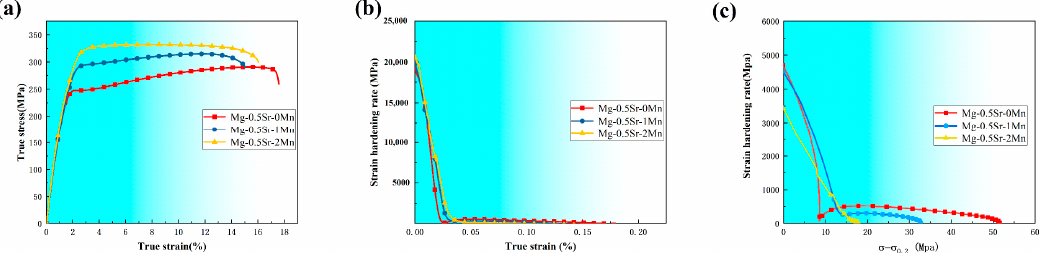
Figure 7. ( a ) Tensile flow curves of the tensile-loaded samples with different Mn; Work-hardening rate curves of the extruded Mg-Sn-Mn alloys: ( b ) θ vs. ε , ( c ) θ vs. ( σ - σ 0.2).